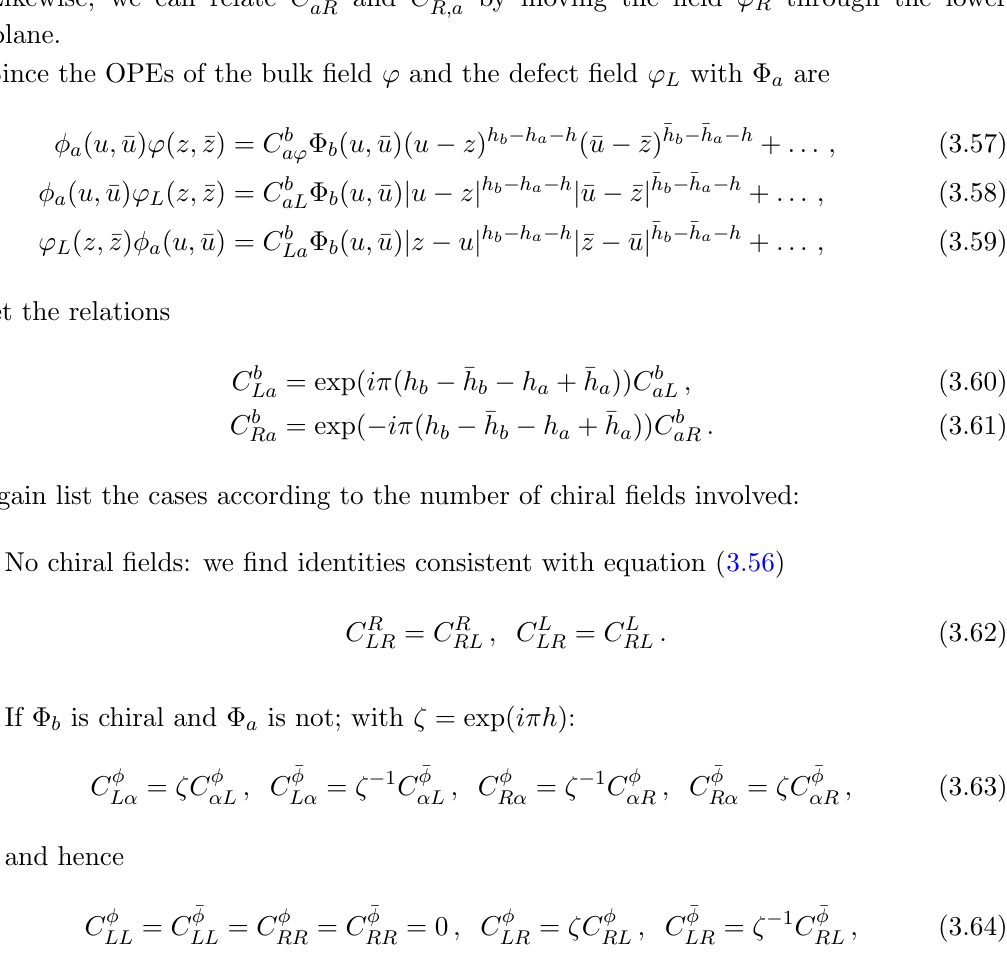
and C b from continuity in the La aL